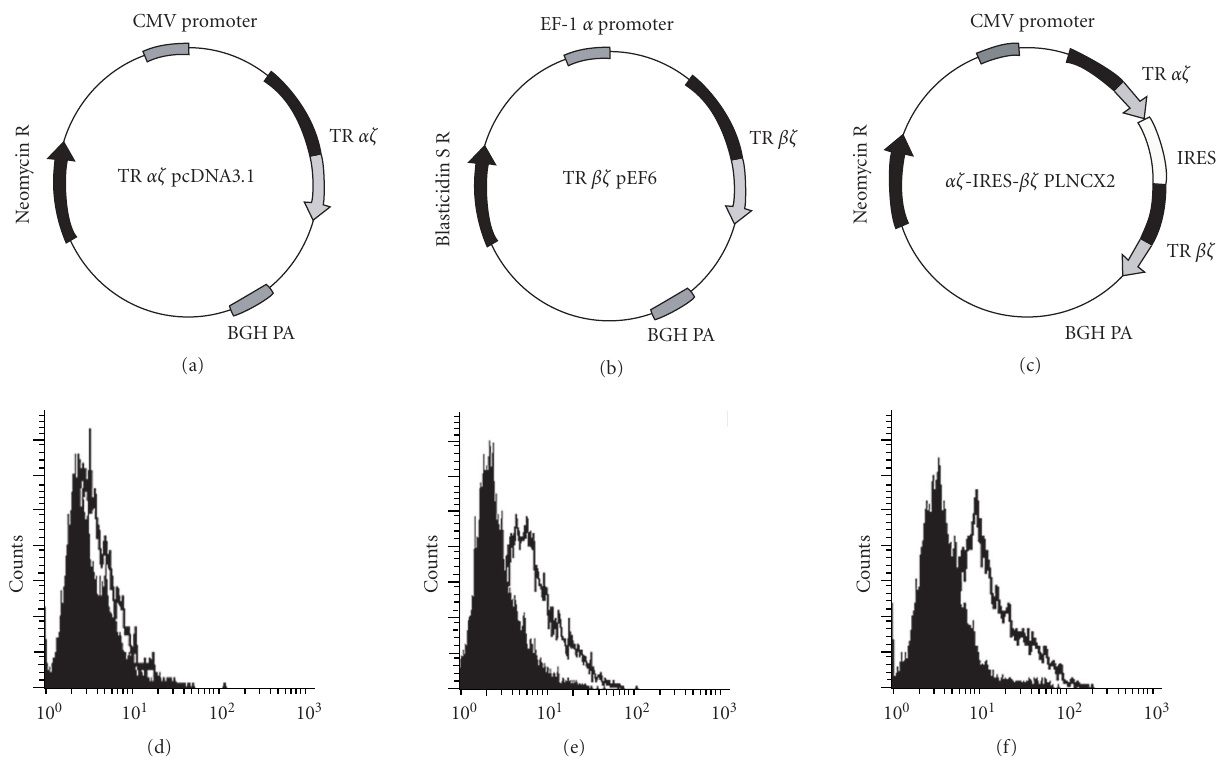
Figure 2: Construction and expression of engineered MUC1-specific TRAZ and TRBZ receptors . Expression vectors for (a) TRAZ, (b) BZ, and (c) AZ/BZ. (d) Untransfected 293H cells, (e) 293H cells cotransfected with the TRAZ and TRBZ, or (f) cells transfected with the AZ-IRES- BZ pLNCX2 were stained for surface expression of the TR using anti-TR antibody BF1 (open histogram) or isotype control antibody (filled